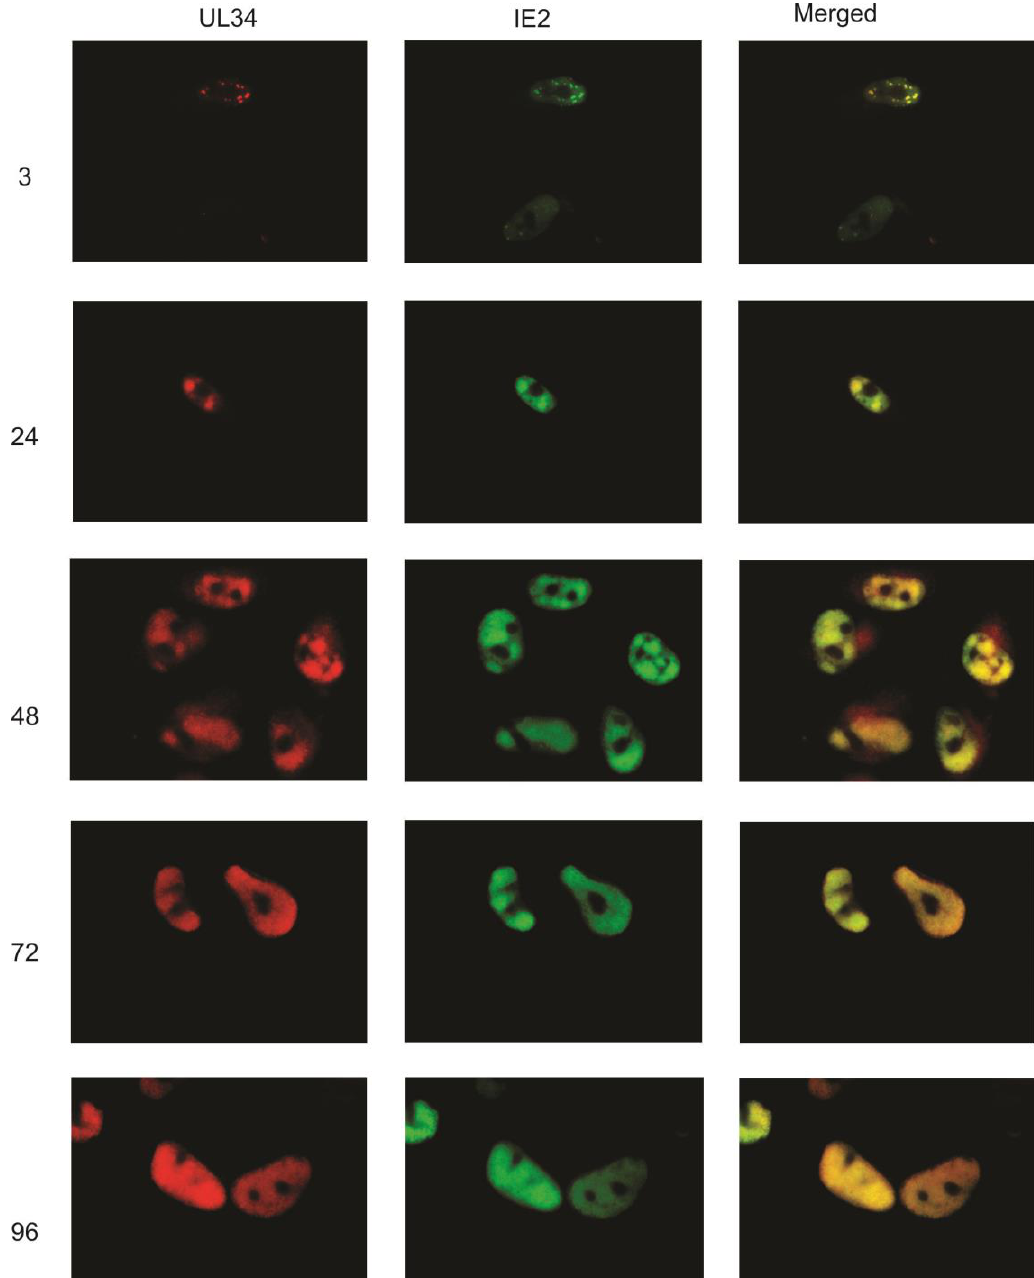
Figure 2. Indirect immunofluorescence was performed on primary human fibroblasts infected with HCMV strain Towne at 3, 24, 48, 72, and 96 hpi using antibodies to UL34 and to IE2. UL34 staining is red, IE2 staining is green; the merged column is the combination of the green and red images. Colocalization is indicated by the yellow color in the merged images. The numbers indicate the time post-infection at which the cells were examined. Control slides, infected cells incubated only with secondary antibodies, are not